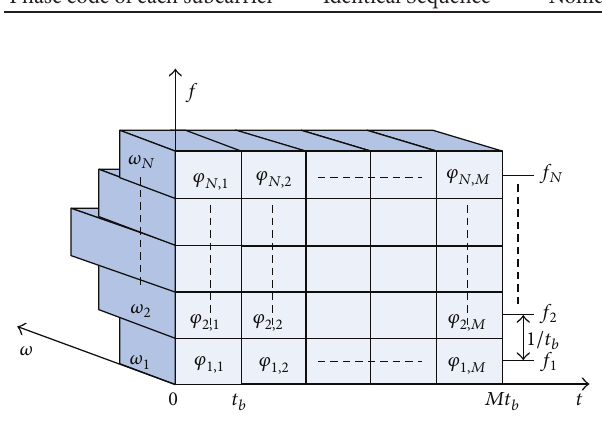
Figure 1: Structure of MCPC